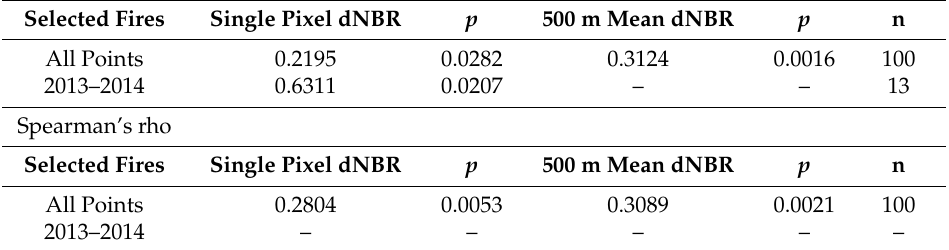
Table 5. Correlations between dNBR and MODIS fire radiative power for select fires.